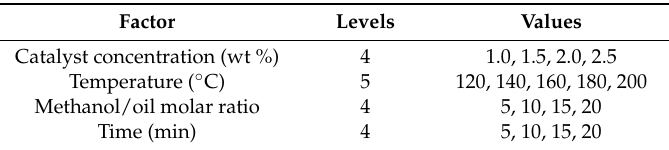
Table 2. Design of experiment.